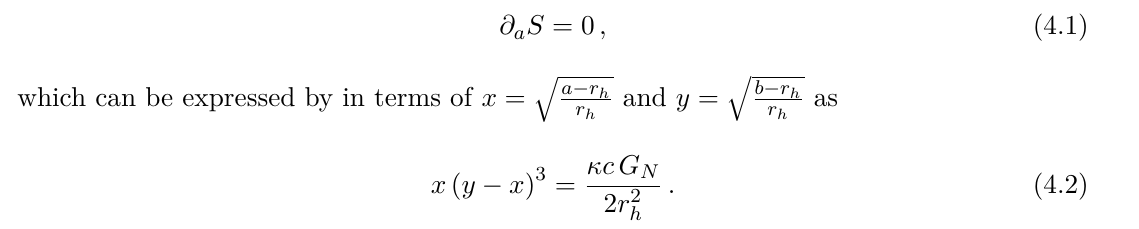
Figure 7 . Phase transition of the quantum extremal surface when the boundary b ± between R and B approaches to the quantum extremal surface, a ± . The graphs show the entanglement entropy of R as a function of the position of the quantum extremal surface x , where x = boundary b ± is not very close to a ± , the entropy has a local minimum and local maximum (left). When, the boundaries b ± have sufficiently approached to a ± , namely at b = b c , the local minimum merges to the local maximum, and then, the entropy has no local minimum